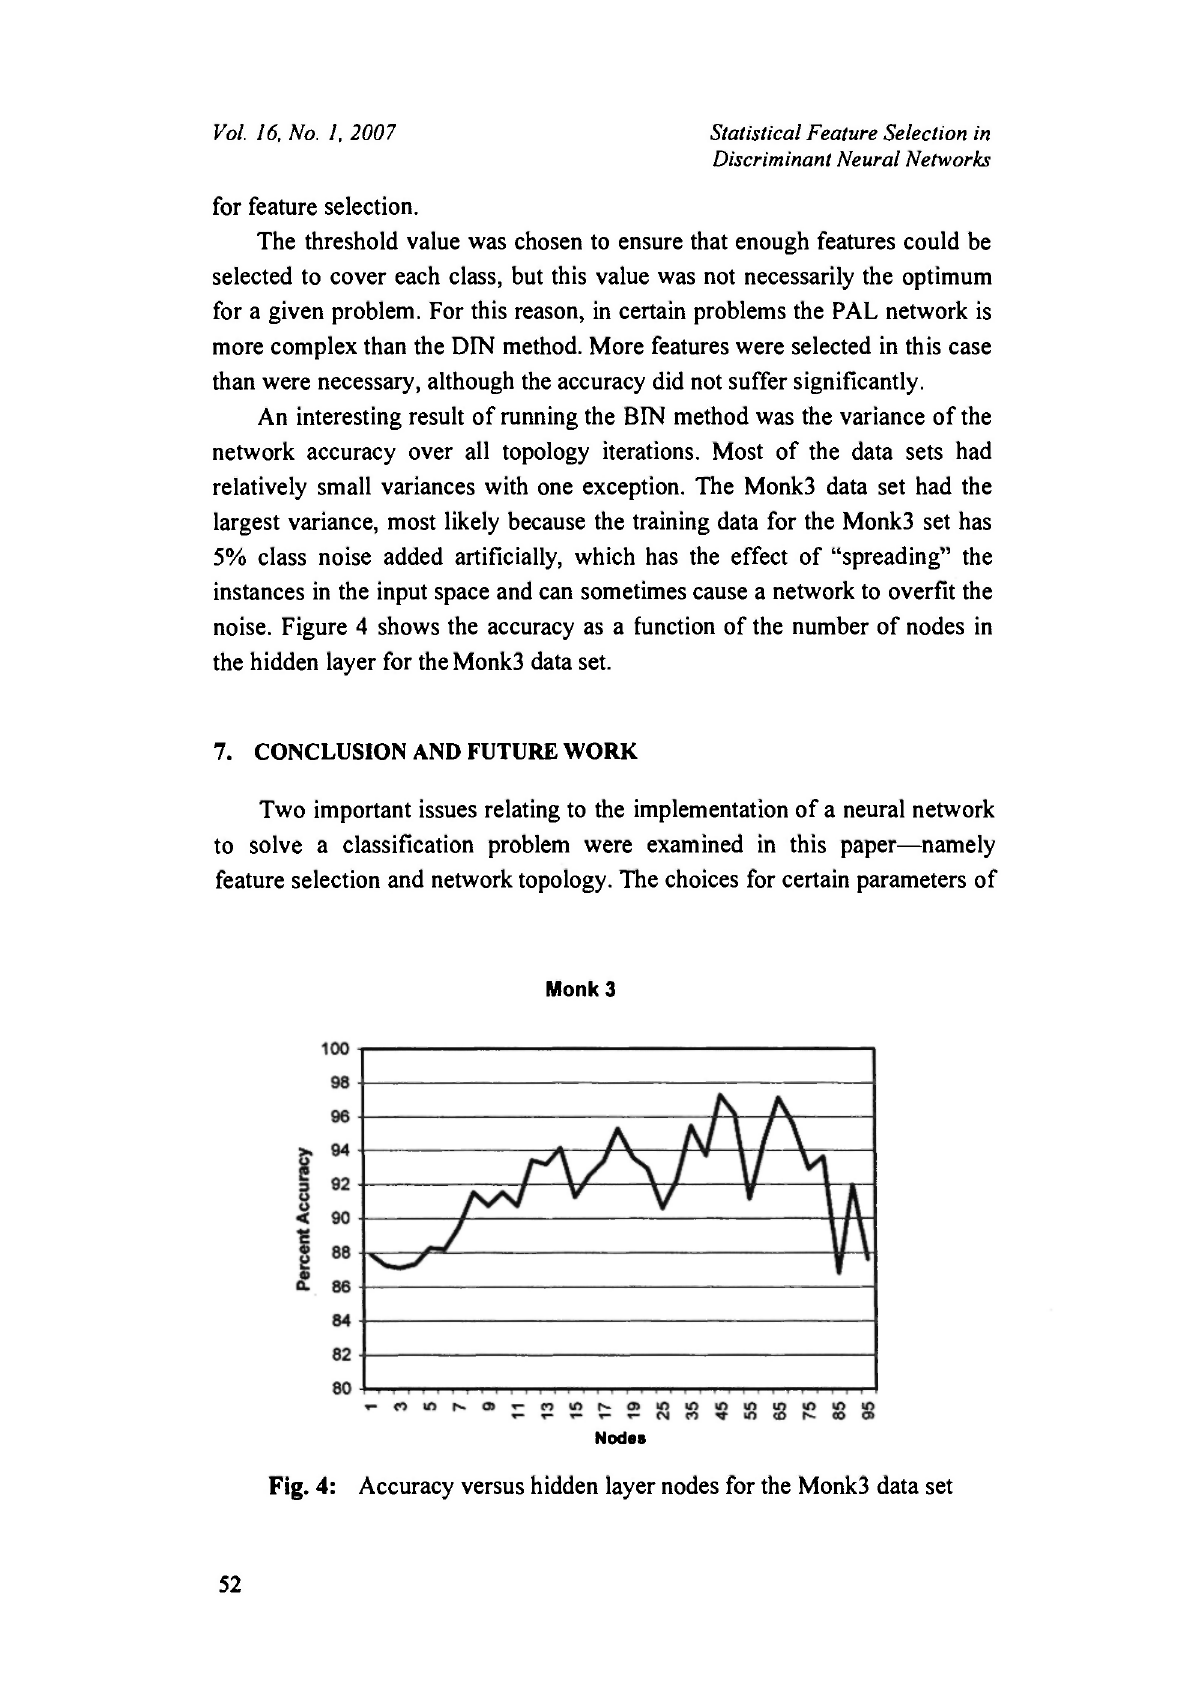
Fig. 4: Accuracy versus hidden layer nodes for the Monk3 data